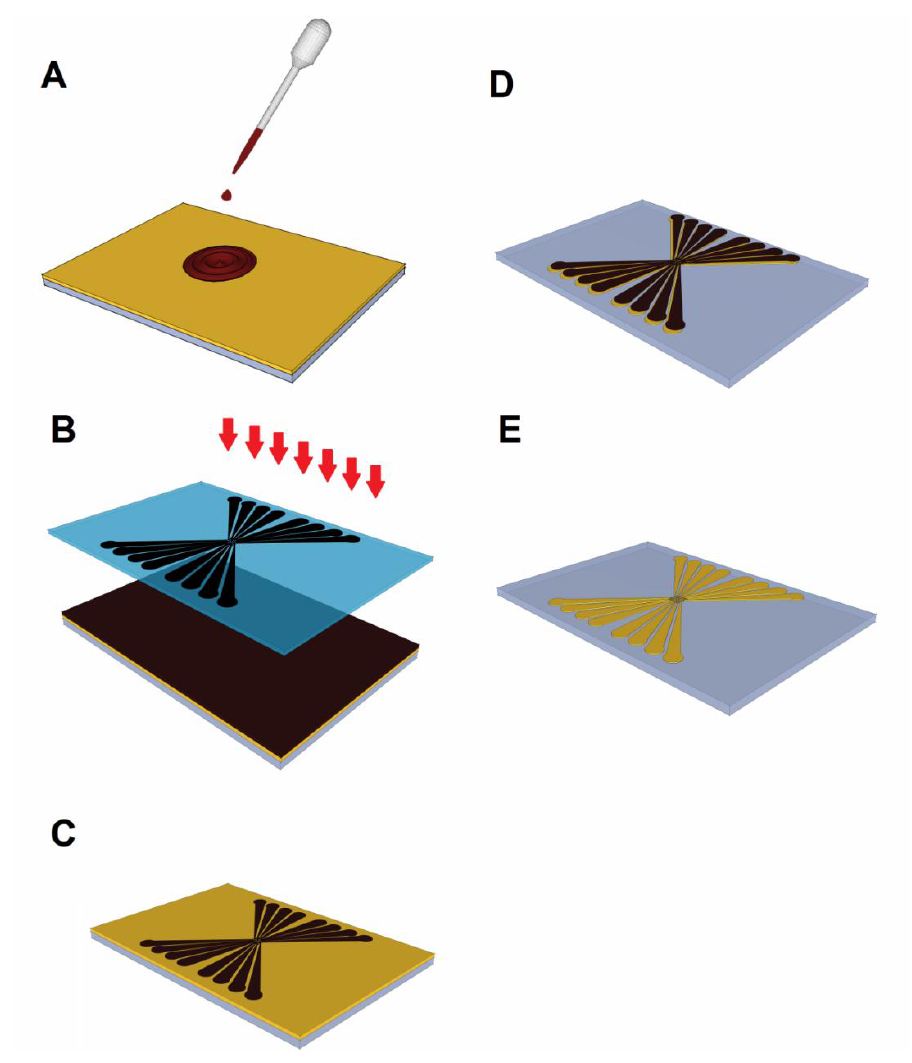
Figure 3. Images of the key steps in the fabrication of planar electrodes by photolithography, including ( A ) photoresist coating, ( B ) UV exposure, ( C ) developing, ( D ) etching, and ( E )